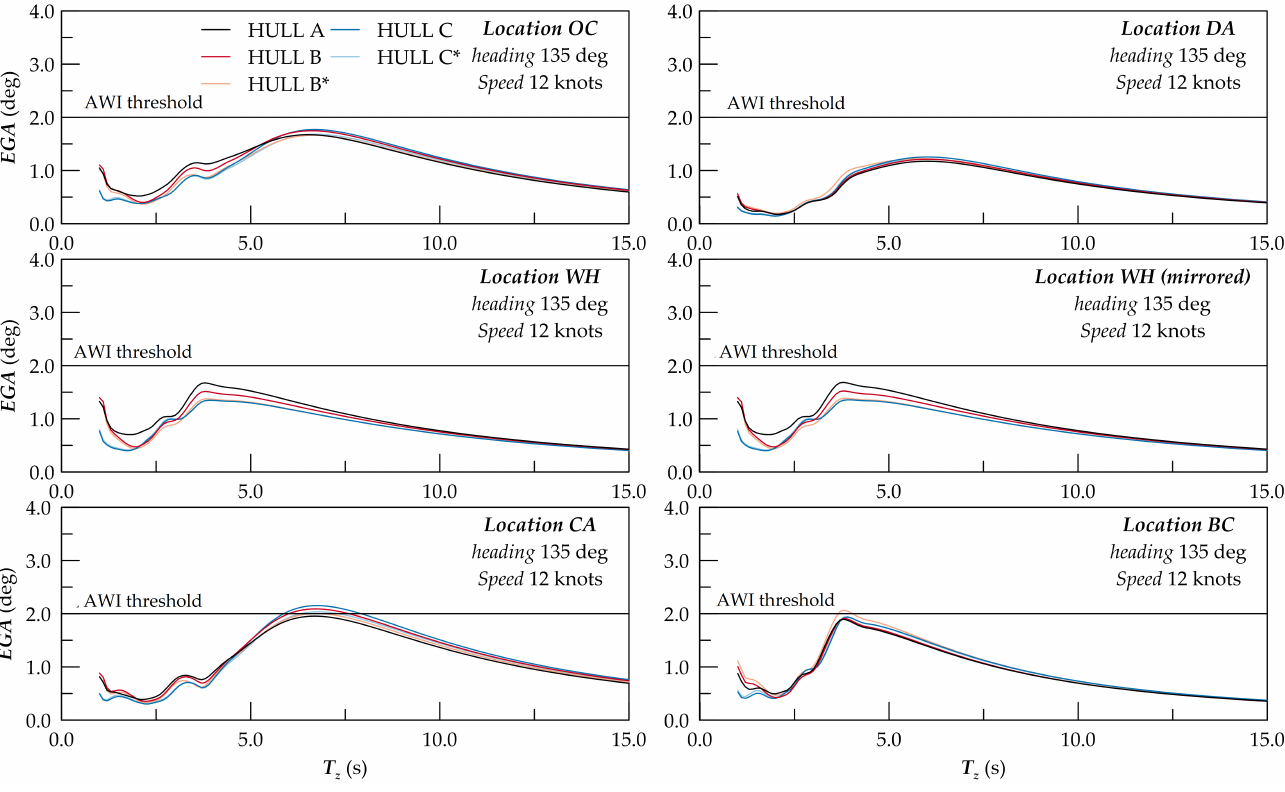
Figure 19. EGA values for H s = 1.5 metres at different T z for the AWI 22834 locations at 12